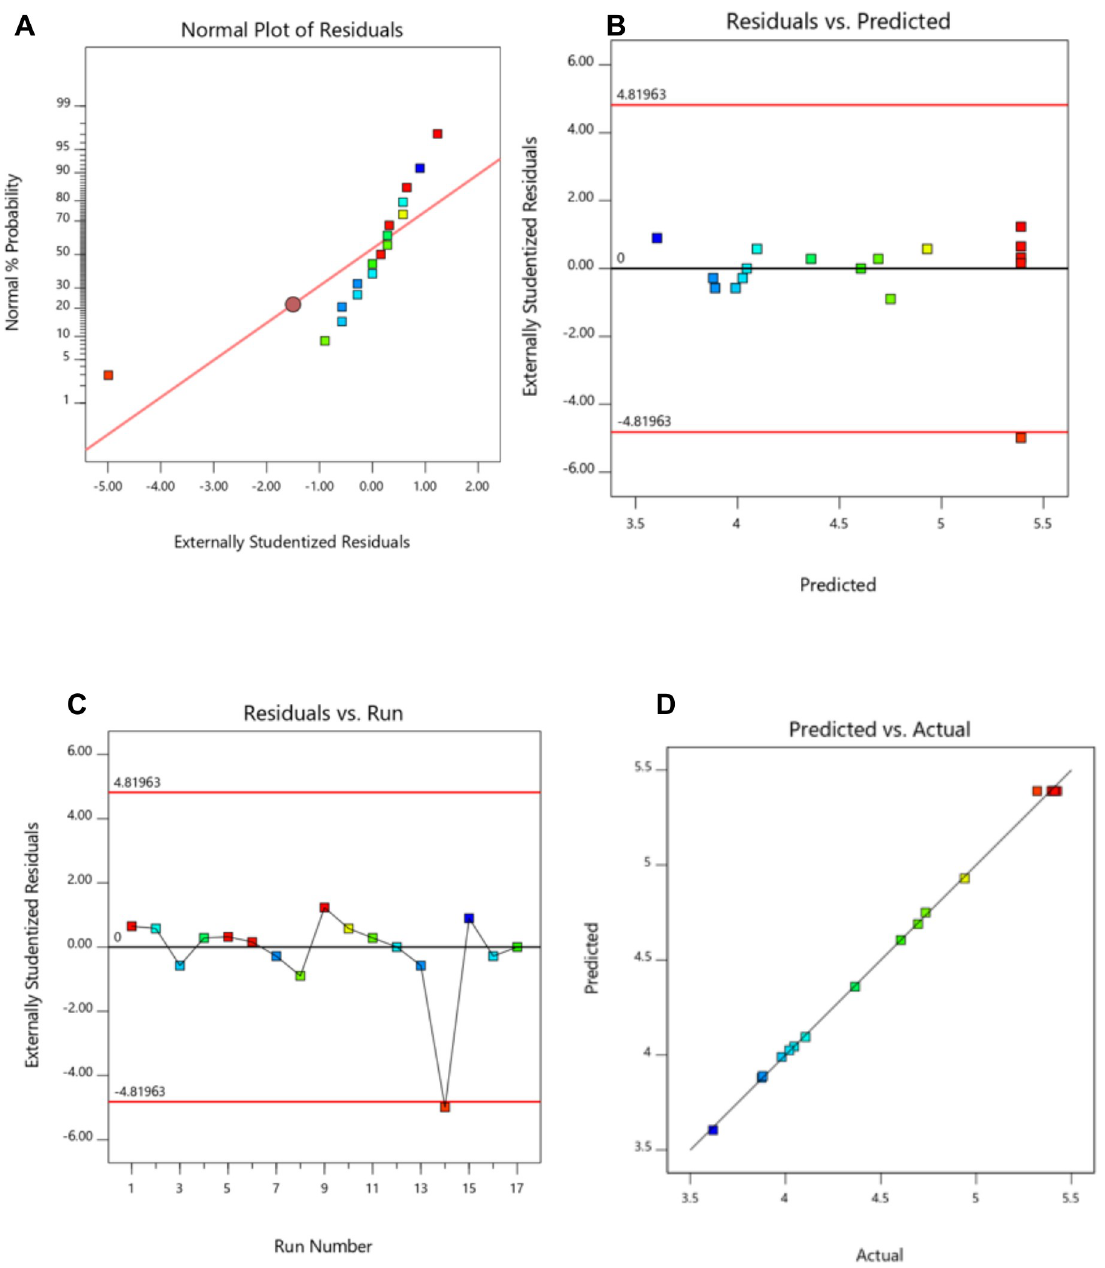
Fig 3. Diagnostic plots for the Box-Behnken model adequacy. (A) Normal plot of residuals, (B) plot of internally studentized residuals vs. predicted response, (C) Residual vs. run and (D). Predicted vs. actual.